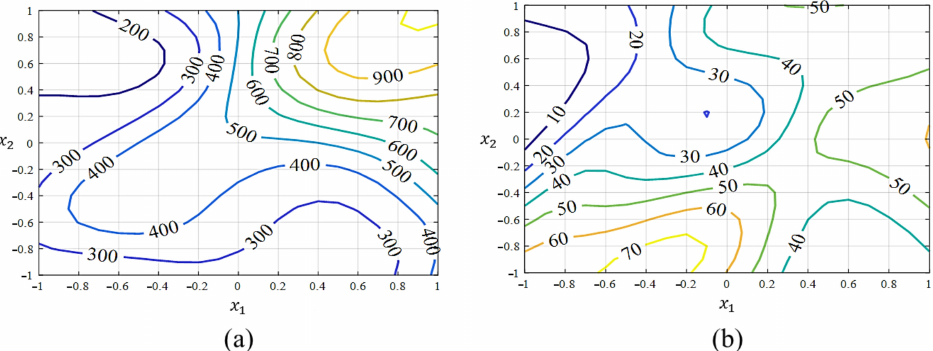
Figure 5. Estimated process mean and standard deviation response functions from the feed-forward NN approach with conventional log-sigmoid transfer function: ( a ) mean ( R 2 = 93.44%); ( b ) standard deviation ( R 2 =